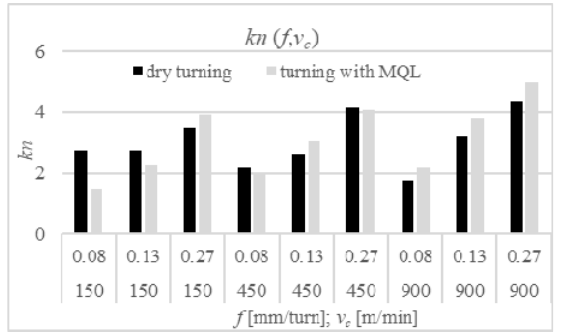
Figure 15. Constancy factor of cutting force Fc in aluminium composite turning with diamond coated carbide tool.